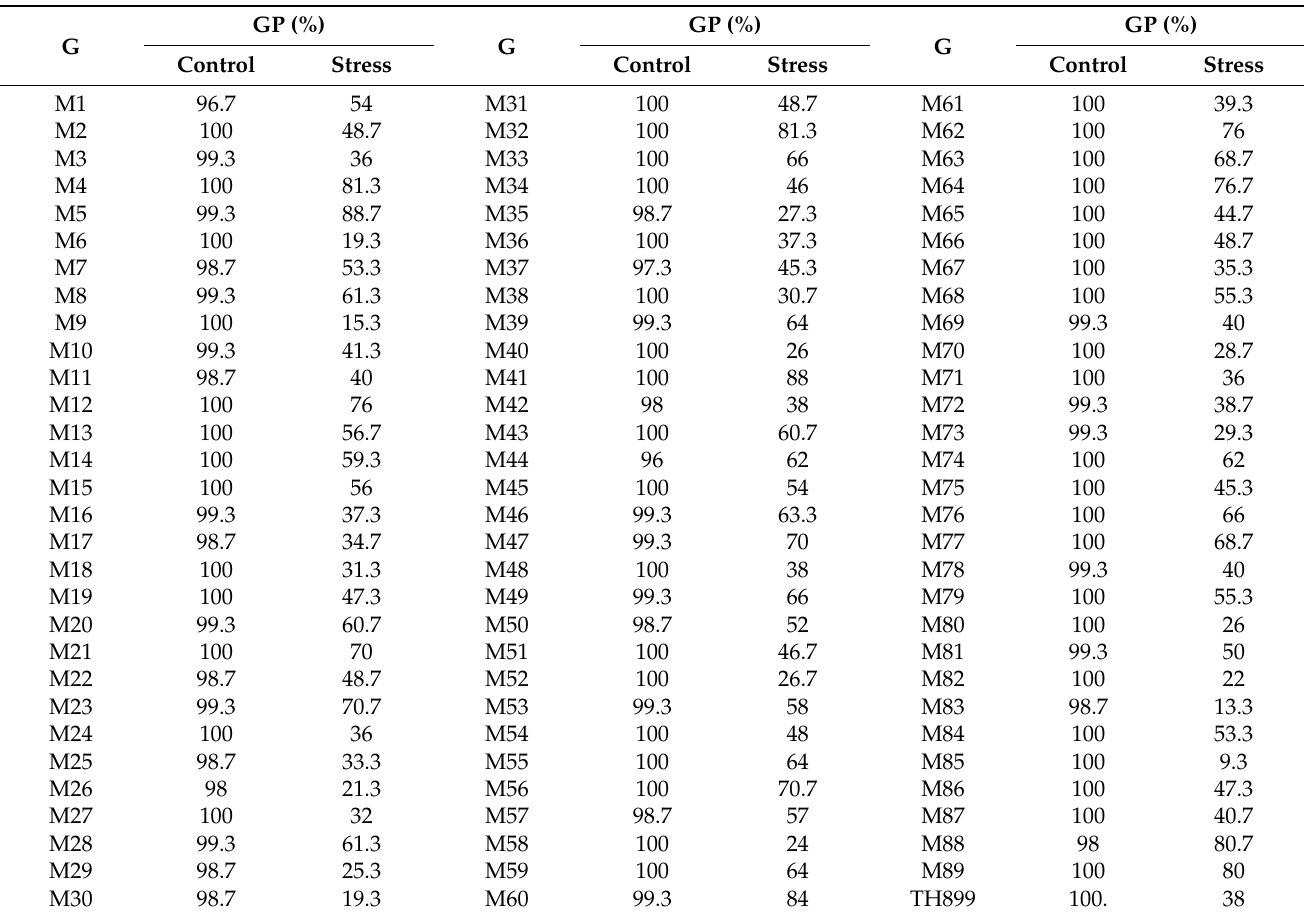
Table 2. Seed germination of mutant lines and TH899 under control and saline–alkaline stress